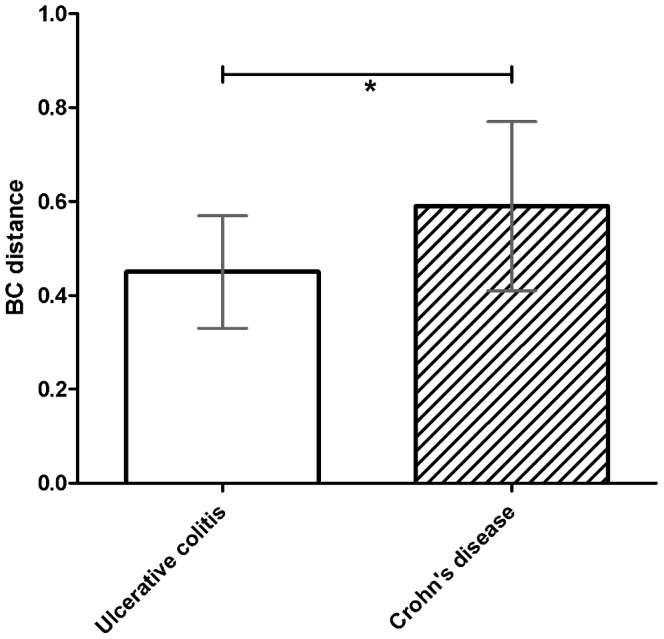
Mean within subjects pair-wise Bray-Curtis distances for ulcerative colitis and Crohn’s disease patients (p = 0.027).*: Significantly different (p<0.05).